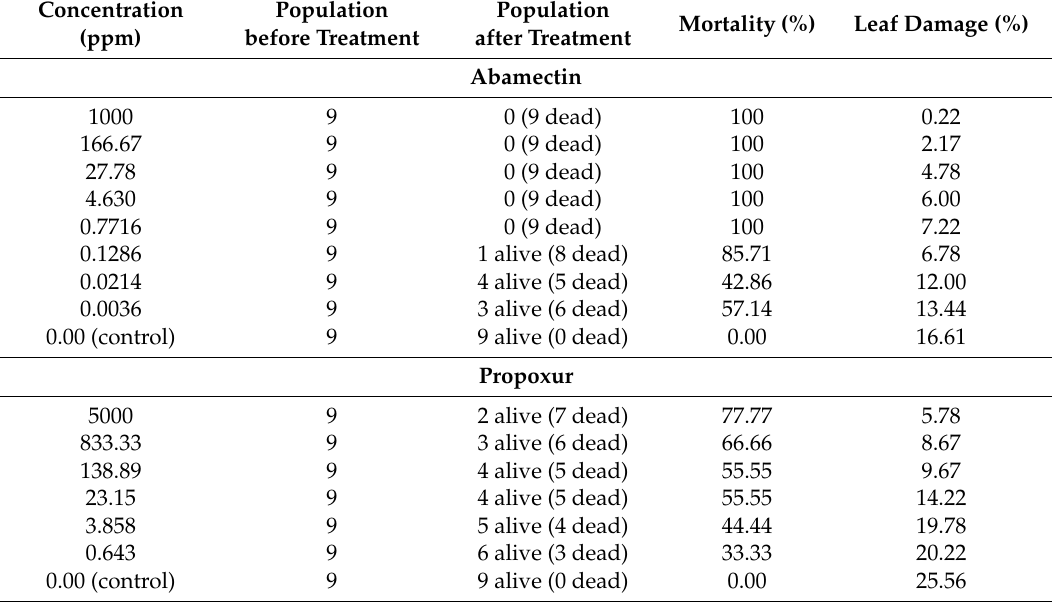
Table 1. Susceptibility profiles mortalities) and leaf damage from exposure to various insecticides and synergists.